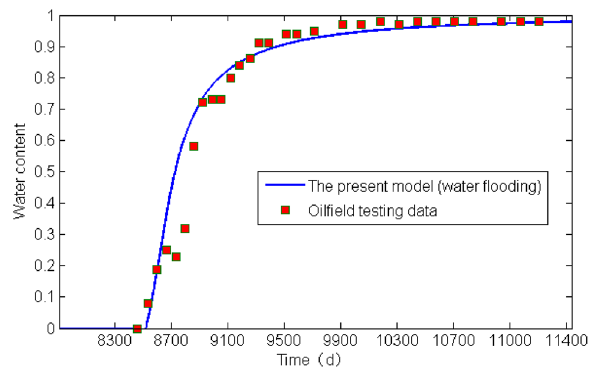
Fig. 7 Water content with different polymer concentrations